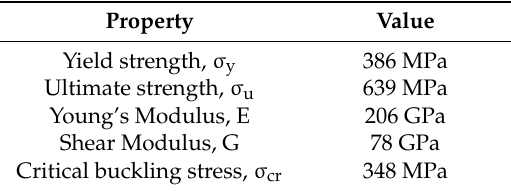
Table 2. Monotonic properties of S355-J2G3